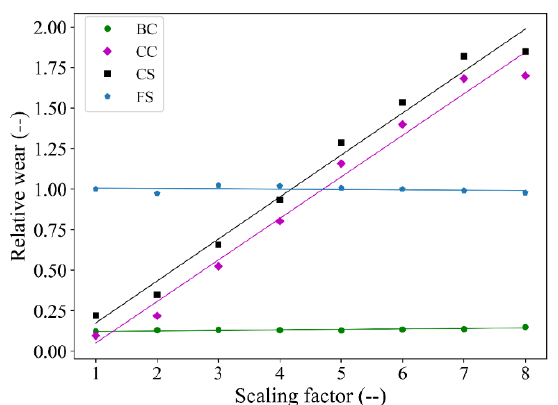
Figure 16. Relative wear vs. scaling factor (CS: convex pattern surface, FS: flat surface, BC: base of CS, CC: convex part of CS).